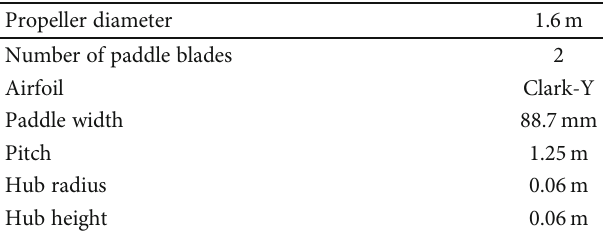
Table 1: Parameters of propeller.